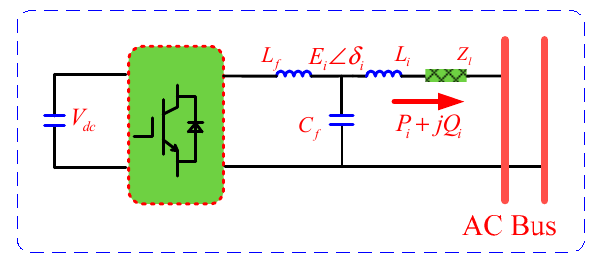
Figure 2. Microgrid–DG connection.